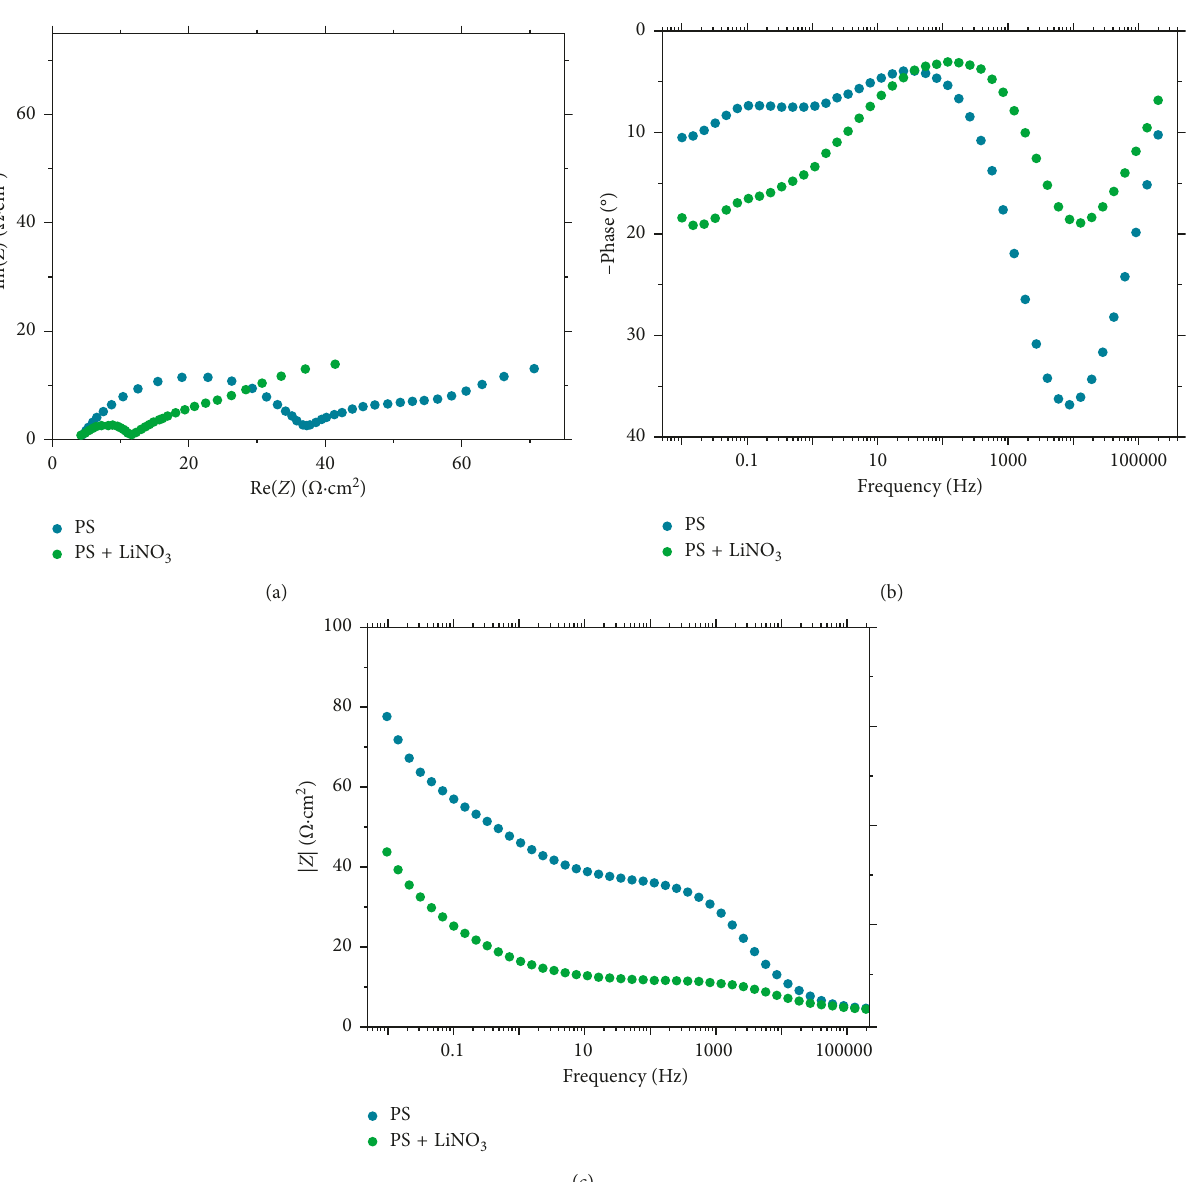
layer before and after electrochemical cycling is presented in Figure 8. The XPS analysis was performed before (Figure 8(a)) and after 30 min Ar + sputtering (Figure 8(b)). The atomic distribution displays a much higher Li con- centration on the surface and a decrease of the quantities for all other elements in the cycled sample (Figure 8(a)), which is probably the reason for the reduced R and total im- int pedance Z . After sputtering, the SEI of the cycled cell (Figure 8(b)) shows a higher concentration of Li in exchange for lower F- and C-content, and the concentration of oxygen and sulfur remains unchanged. This chemical